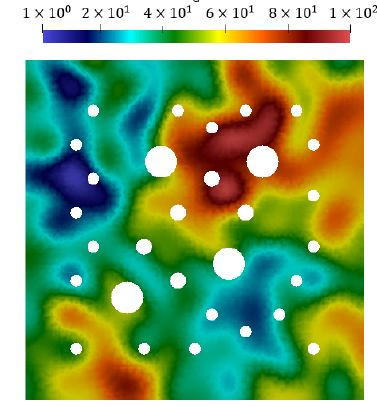
Figure 15. Heterogeneous